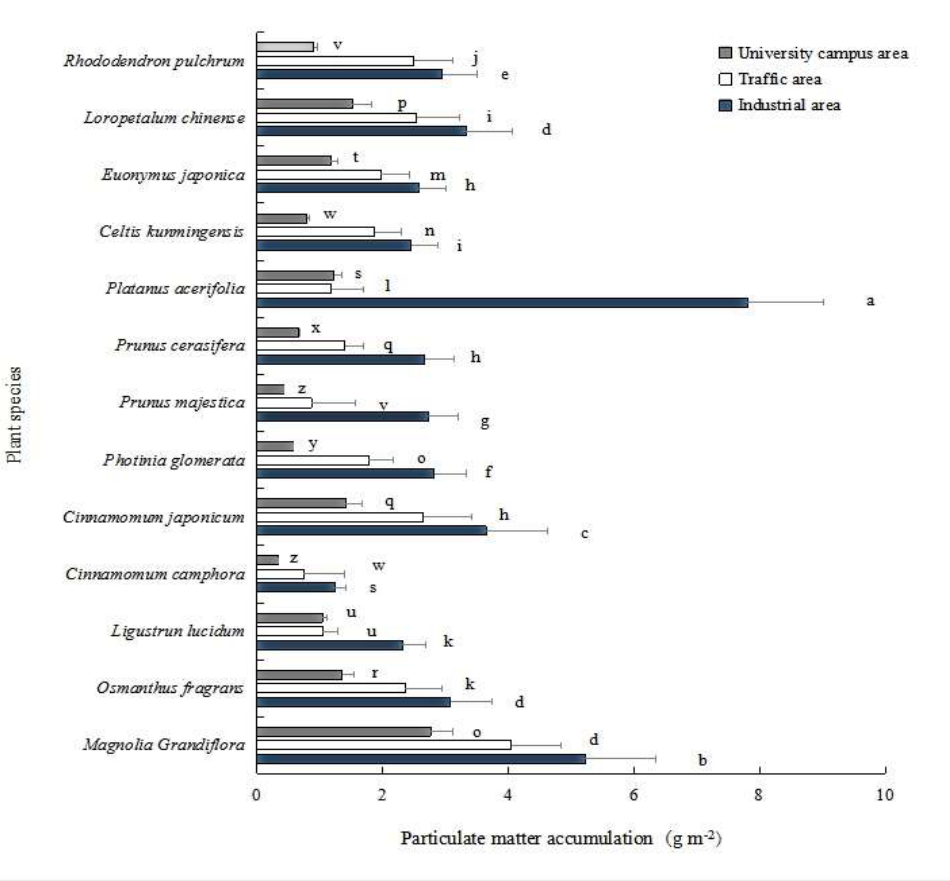
Figure 5. Particulate matter accumulated on leaf surfaces of trees and shrub species in three functional zones (industrial, traffic and university campus) in Kunming City, China. Bars are means ± SE. Treatments with the same letter were not significantly different (ANOVA with Duncan test, p < 0.05).